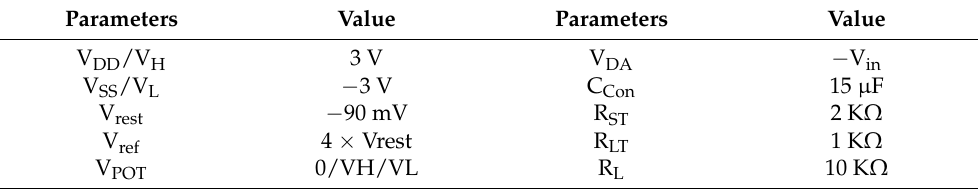
Table 2. Circuit parameters of the neuro-memristive synapse that used in